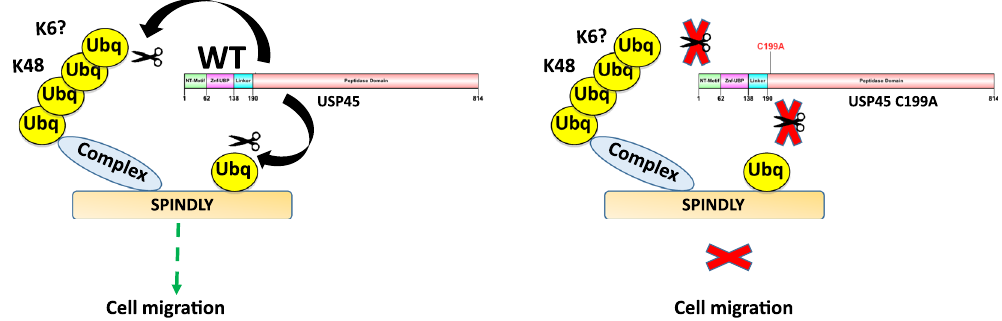
Figure 6. Model of USP45 and Spindly interaction. Proposed model illustrating the interaction between USP45 and Spindly. Interaction is dependent on USP45 catalytic activity. Spindly is mono-ubiquitylated and this ubiquitin can be removed by active USP45. K48 ubiquitylated complex that interacts with Spindly is also de- ubiquitylated by USP45. In the absence of USP45 catalytic activity, interaction is abolished and cell migration is affected similarly to the phenotype described for lack of